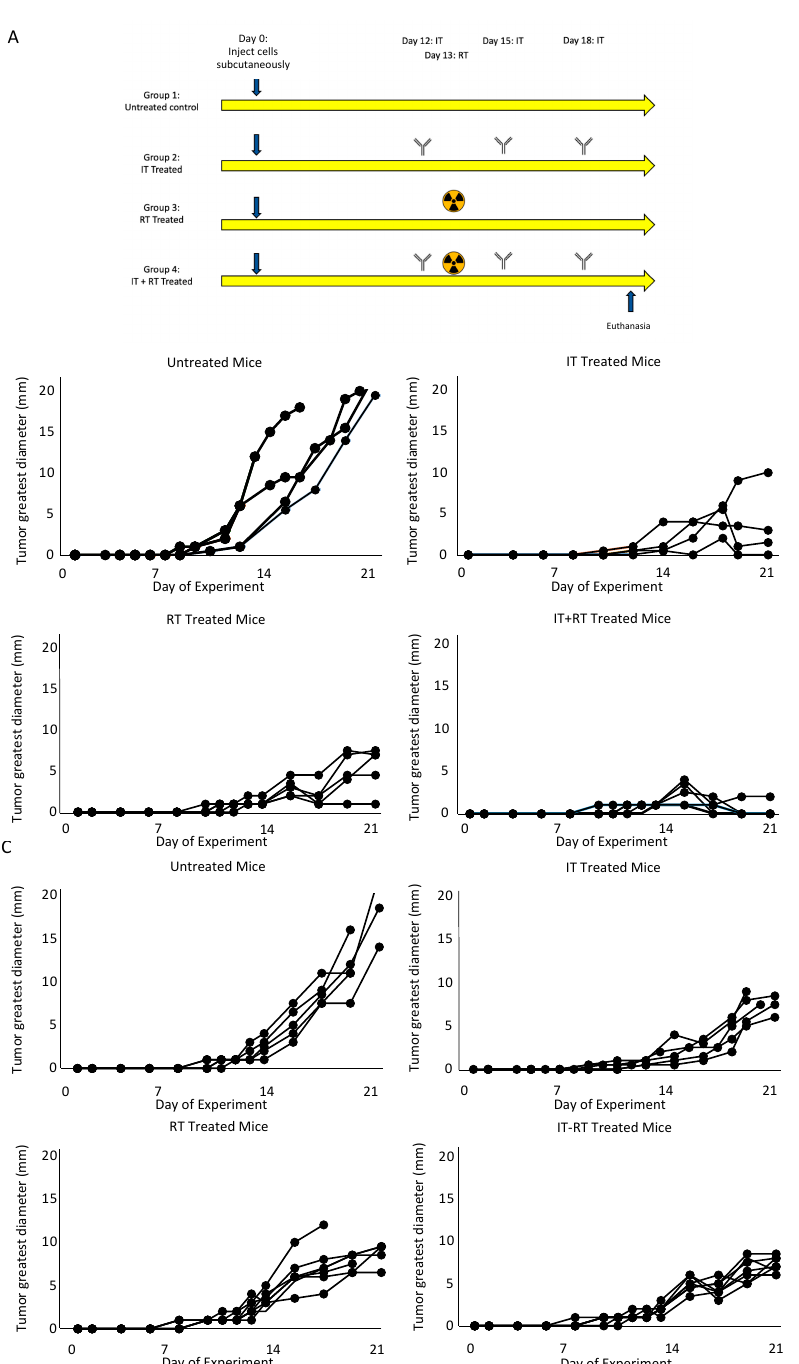
Figure 1. Experimental plan and tumor growth curves. ( A ) demonstrates the treatment regimen used in this study. Tumor growth curves for melanoma ( B ) and lung cancer ( C ) for each condition demonstrated responsiveness to both immunotherapy and